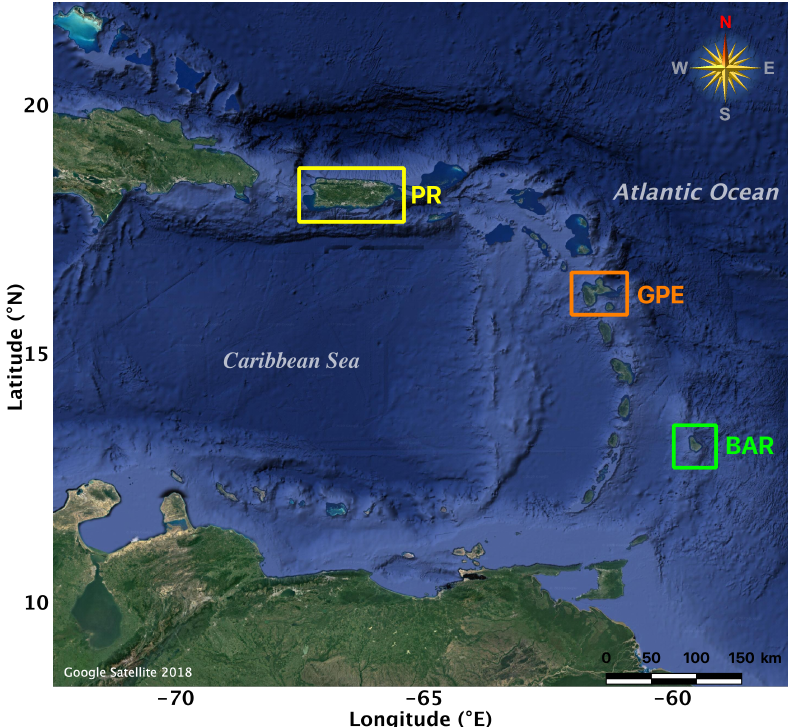
Figure 1. Overview of the Caribbean area with, respectively, from top to the bottom Puerto Rico (18.23 ◦ N, − 66.50 ◦ W; PR in yellow), Guadeloupe archipelago (16.25 ◦ N, − 61.58 ◦ W; GPE in orange), and Barbados (13.16 ◦ N, − 59.55 ◦ W; BAR in